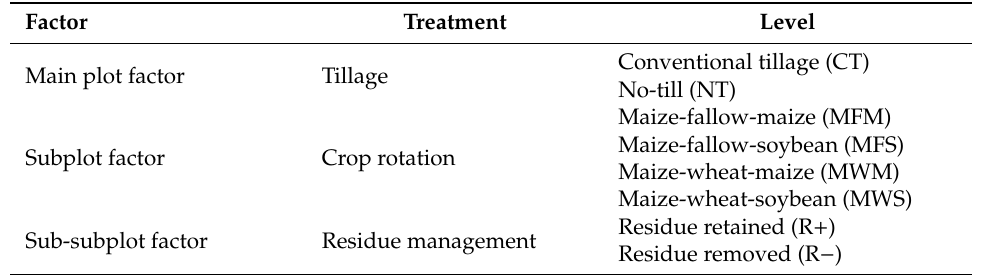
Table 1. A summary of the treatment factors for the split-split-plot field experiment. Factor Main plot